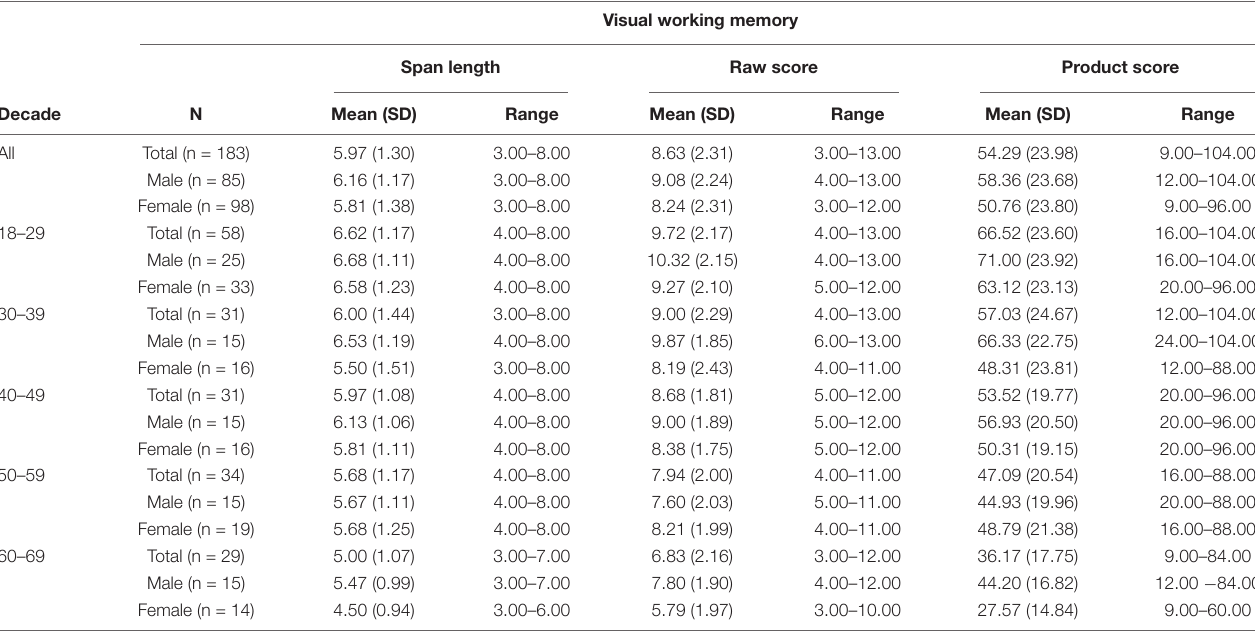
TABLE 2 | Descriptive data for the backward corsi tapping task (i.e., visual working memory): span length (longest correctly remembered sequence, range: 2 – 8), raw score (number of correctly remembered trials, range: 0 – 14), and product score (compound score of span length and raw score, range: 0 – 112).